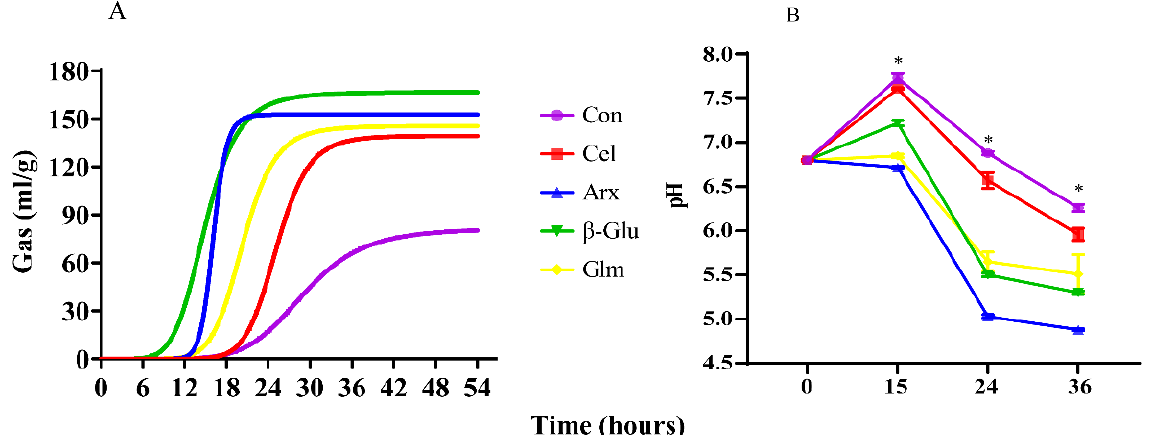
Figure 1. In vitro gas production curve ( A ) and pH changes ( B ) over time during fermentation. The results were analyzed by the one-way ANOVA with Tukey’s post hoc test ( n = 5, * mean p < 0.05; Con, control; Cel, cellulose; Arx, arabinoxylan; β − Glu, β − glucan; Glu, glucomannan). Table 2. The fermentation kinetics of different polysaccharides in cumulative gas production trial.